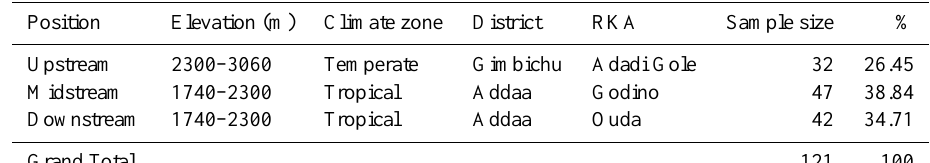
Table 1. Distribution of sample respondents in the Modjo